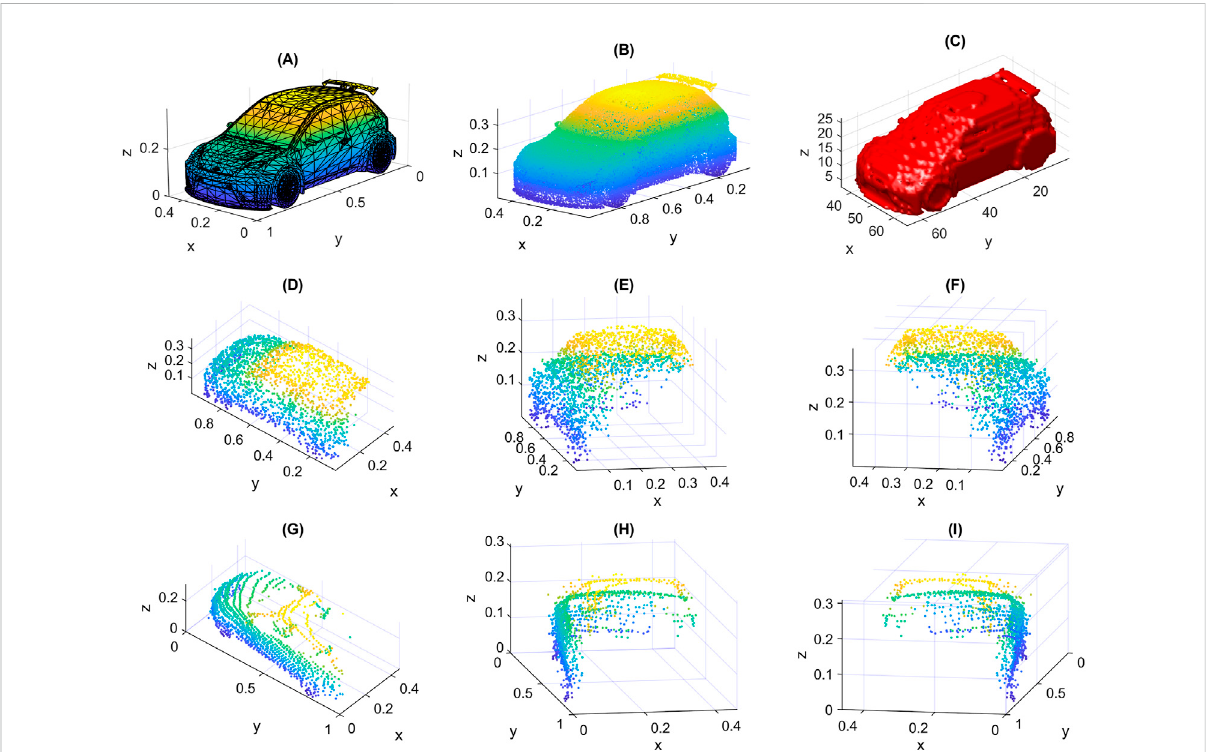
FIGURE 7 An illustrative example: (A) input original object from ModelNet40 dataset with mesh representation, (B) result of random sampling of all elementary surfaces (1e5 points), (C) resulted occupancy grid with size 64 × 64 × 64, (D – F) a created sample shown from three different viewpoints, (G – I) a real sample from Sydney Urban Objects dataset also shown from three different viewpoints.